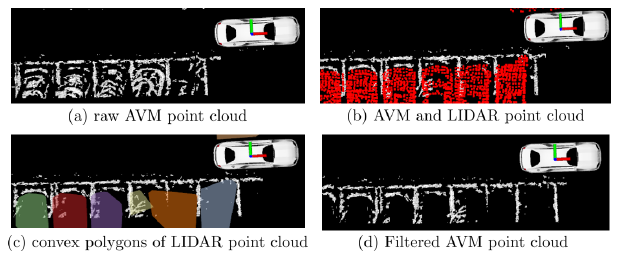
Figure 4. The process of LiDAR-based filtering to extract parking line feature. ( a ) Raw AVM point cloud without filtering the parked vehicle data. ( b ) The AVM and LiDAR data are registered in the map. ( c ) Convex polygons are generated by applying a convex hull to the obstacle data. ( d ) Filtered point cloud.